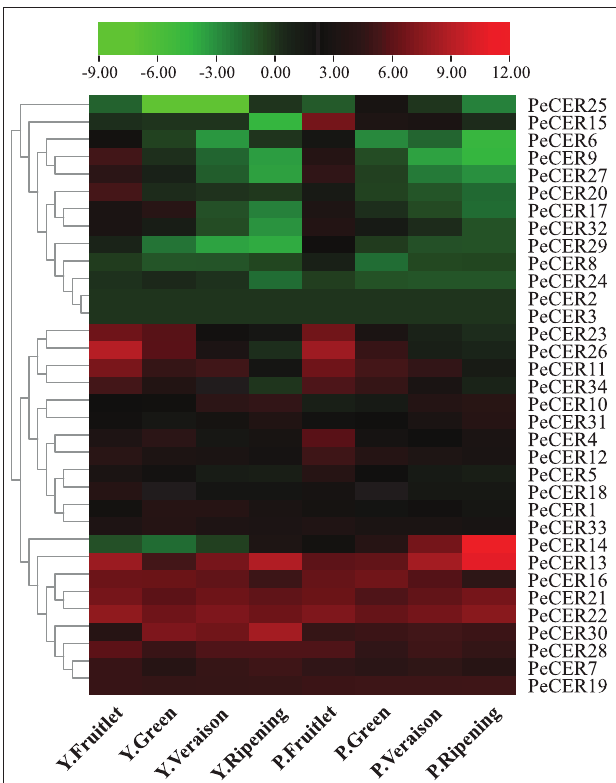
FIGURE 10 | Expression profiles of PeCER genes in pulp tissue of yellow and purple passion fruit cultivars in four fruit development stages. Y and L represent the yellow (Y) and purple (P) passion fruit cultivars. FPKM values were transformed by log2, and heatmap was constructed with the TBTools software. The red color shows the highest and the blue color shows the lowest expression levels in expression